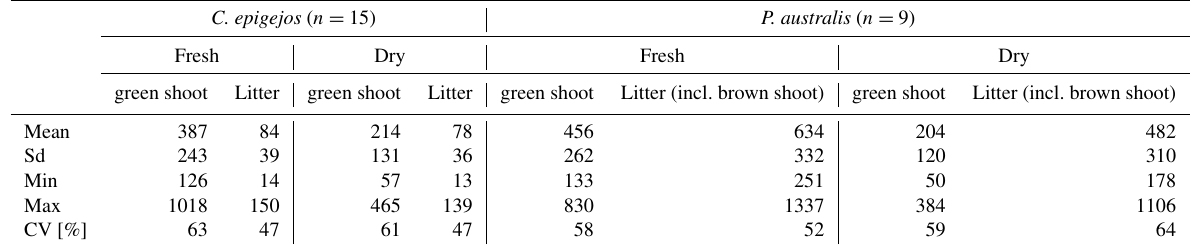
Table 2. Mean, standard deviation (SD), min, max and coefficient of variation (CV) calculated for fresh and dry biomass samples of C. epigejos and P. australis . All units in [gm − 2 ].